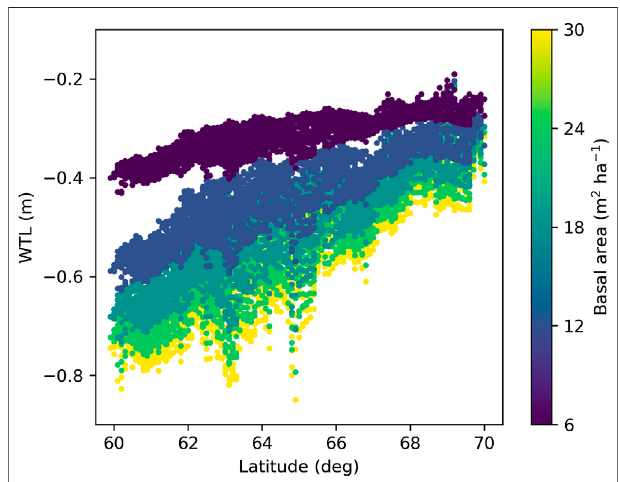
FIGURE 9 | Mean June – October water table level (WTL) predicted with weather data produced by climate models for Finland under current climate